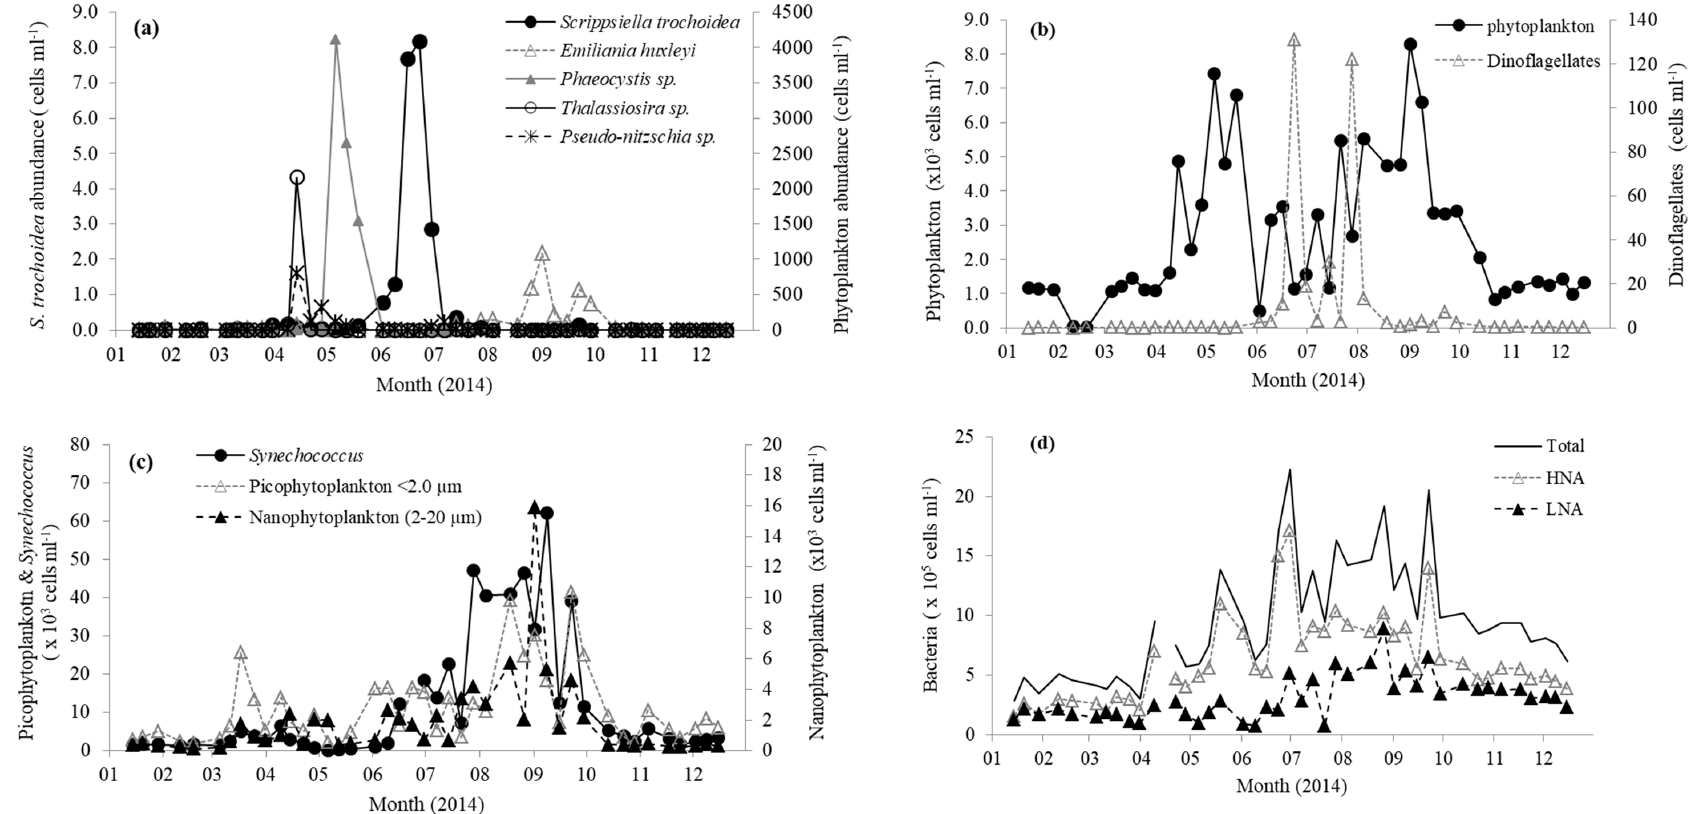
Figure 2. Abundance of ( a ) individual phytoplankton species; ( b ) total phytoplankton and dinoflagellate cells; ( c ) Synechococcus , pico, and nanophytoplankton; and ( d ) total bacterioplankton in surface waters of station L4 in the western English Channel during 2014. HNA, high nucleic acid; LNA, low nucleic acid.